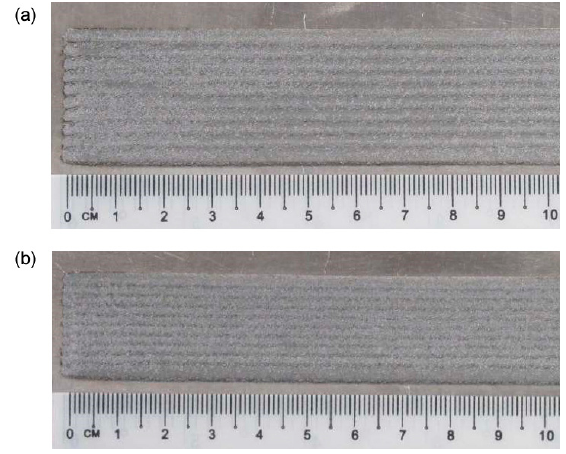
Figure 6. Surface aspects, multi-track, single-layer deposition: ( a ) 33% OR ; ( b ) 50% OR .